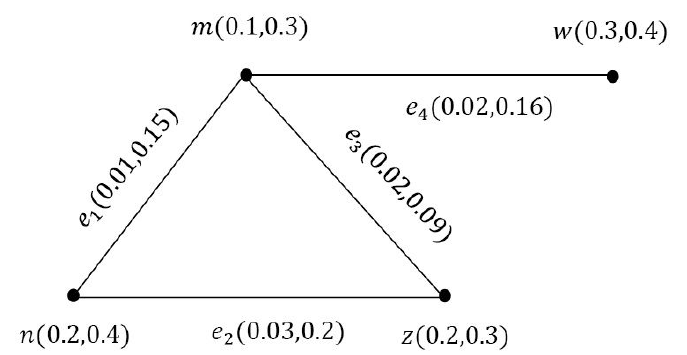
Figure 6. Product vague graph ζ with independent edge sets.